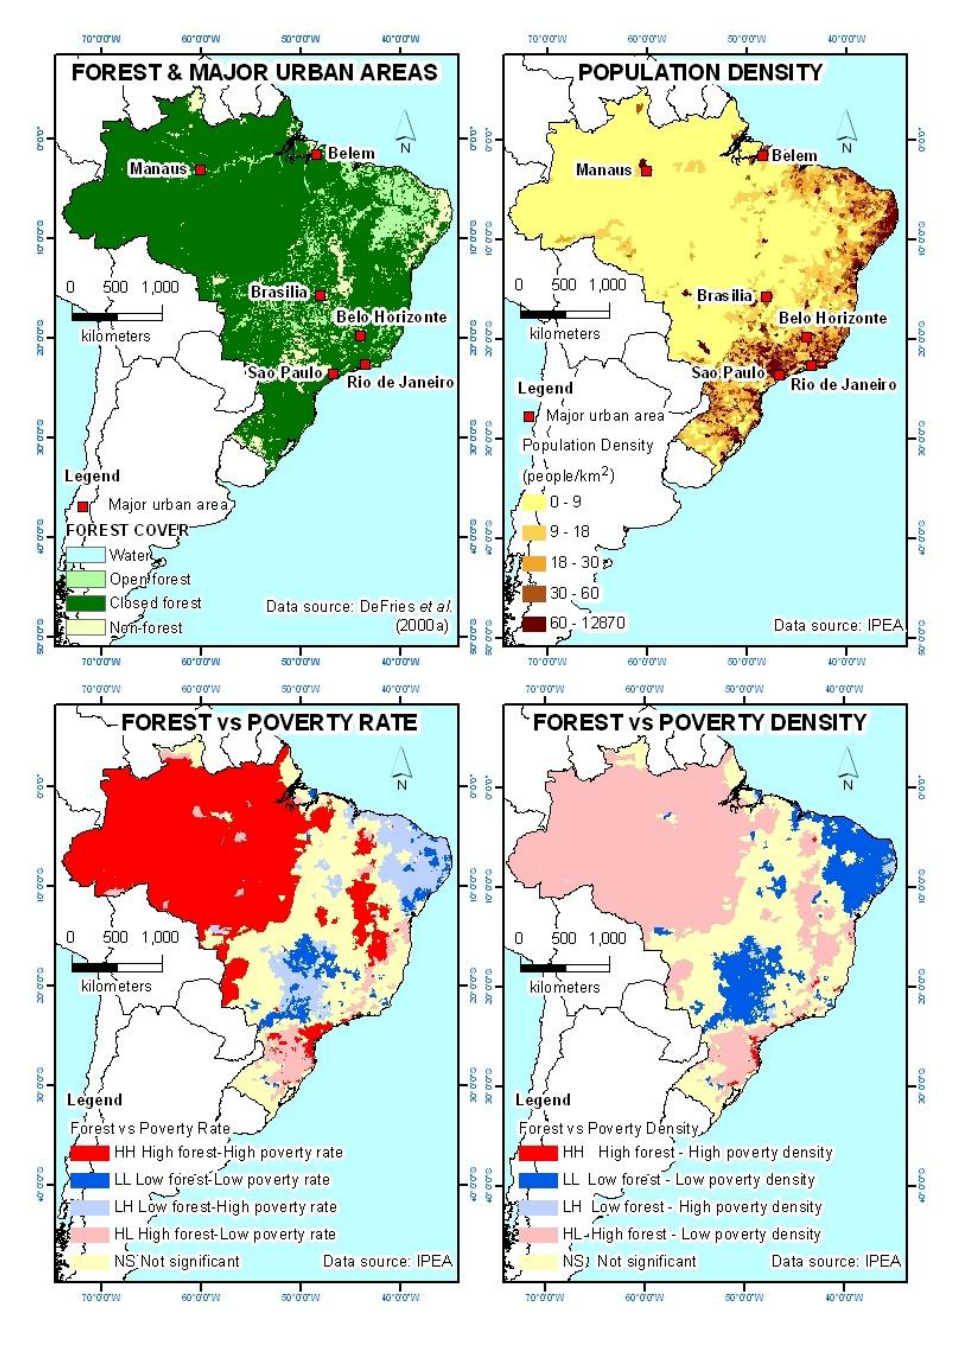
Fig. 1. Brazil. Maps of forest and major urban areas, population density, local indicators of spatial association (LISA) analysis of forest cover by poverty rate, and LISA analysis of forest cover by poverty density. District boundaries are not displayed to show the color patterns more